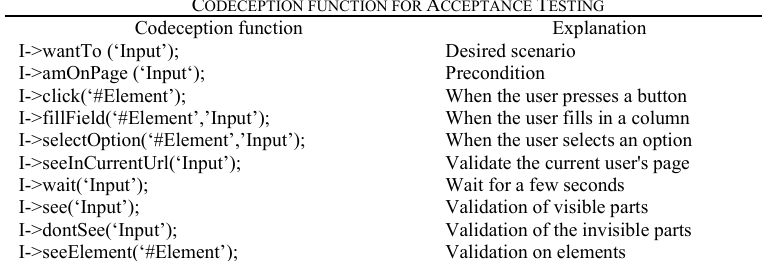
TABLE 1 C ODECEPTION FUNCTION FOR A CCEPTANCE T